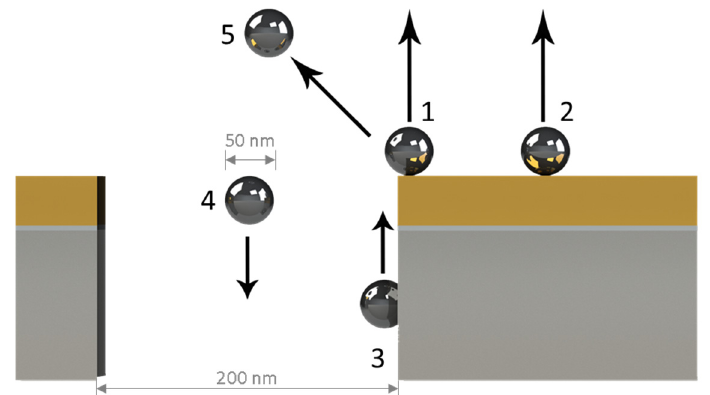
Figure 3. Simulation configurations for different positions of NPs on the NHA surface. In Configuration 1, the Ag-NPs are located on the surface at the rim of the nanohole. In Configuration 2, the NPs are located 150 nm away from the center of the nanohole on the surface of the metal. In Configuration 3, the NPs are in contact with the nanohole’s inner wall. In Configuration 4, the particles are at the center of the nanohole. In Configuration 5, the particles are placed on the edge of the nanohole at 45 degrees. For each configuration, the distance between the NPs and the surface of the nanoholes is varied along the z -axis, except in Configuration 5, where the particles are moved away from the edge at 45 degrees.